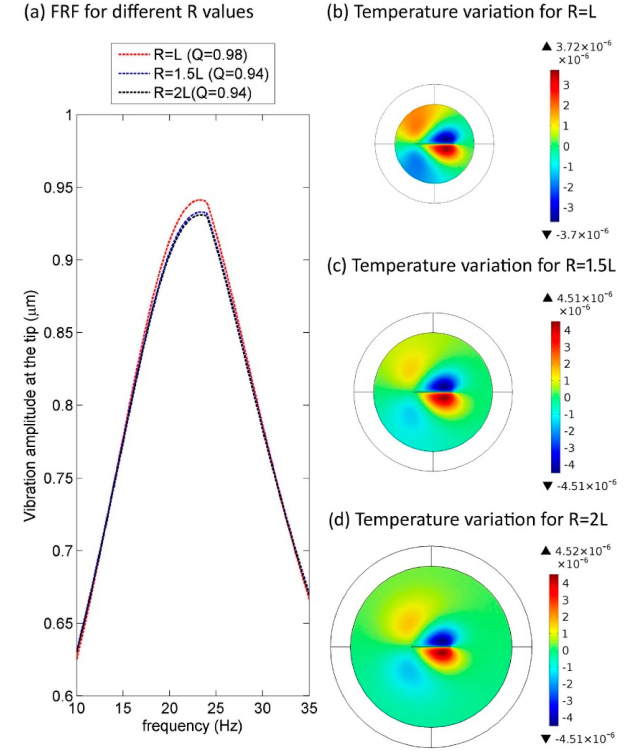
Figure 6. The effect of thermoacoustic sphere radius (R) on the temperature variation distribution and Q factor for the first mode of Ag 2 Ga